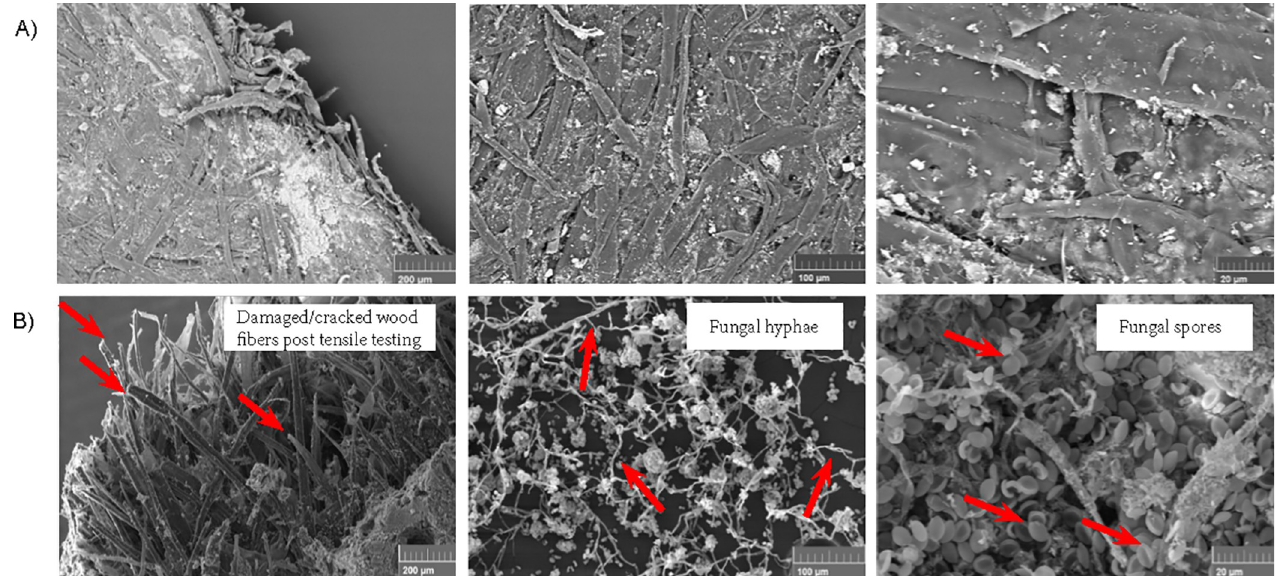
Fig 6. SEM micrographs of gypsum board samples. SEM of (A) the control pieces which were UV sterilized and not exposed to dust and high humidity conditions, and (B) the gypsum board pieces post tensile testing upon 4 weeks of exposure to dust and high humidity conditions.